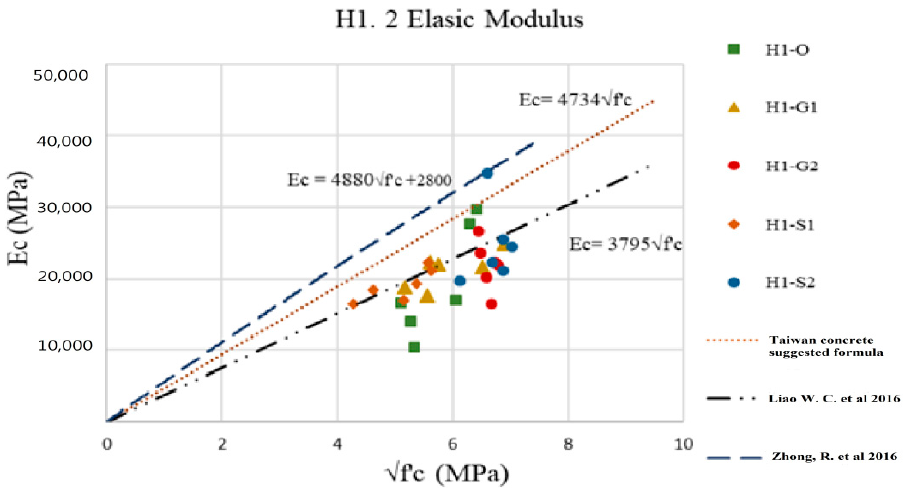
Figure 9. Elastic modulus distribution diagram for H1.2 high-strength pervious concrete speci-